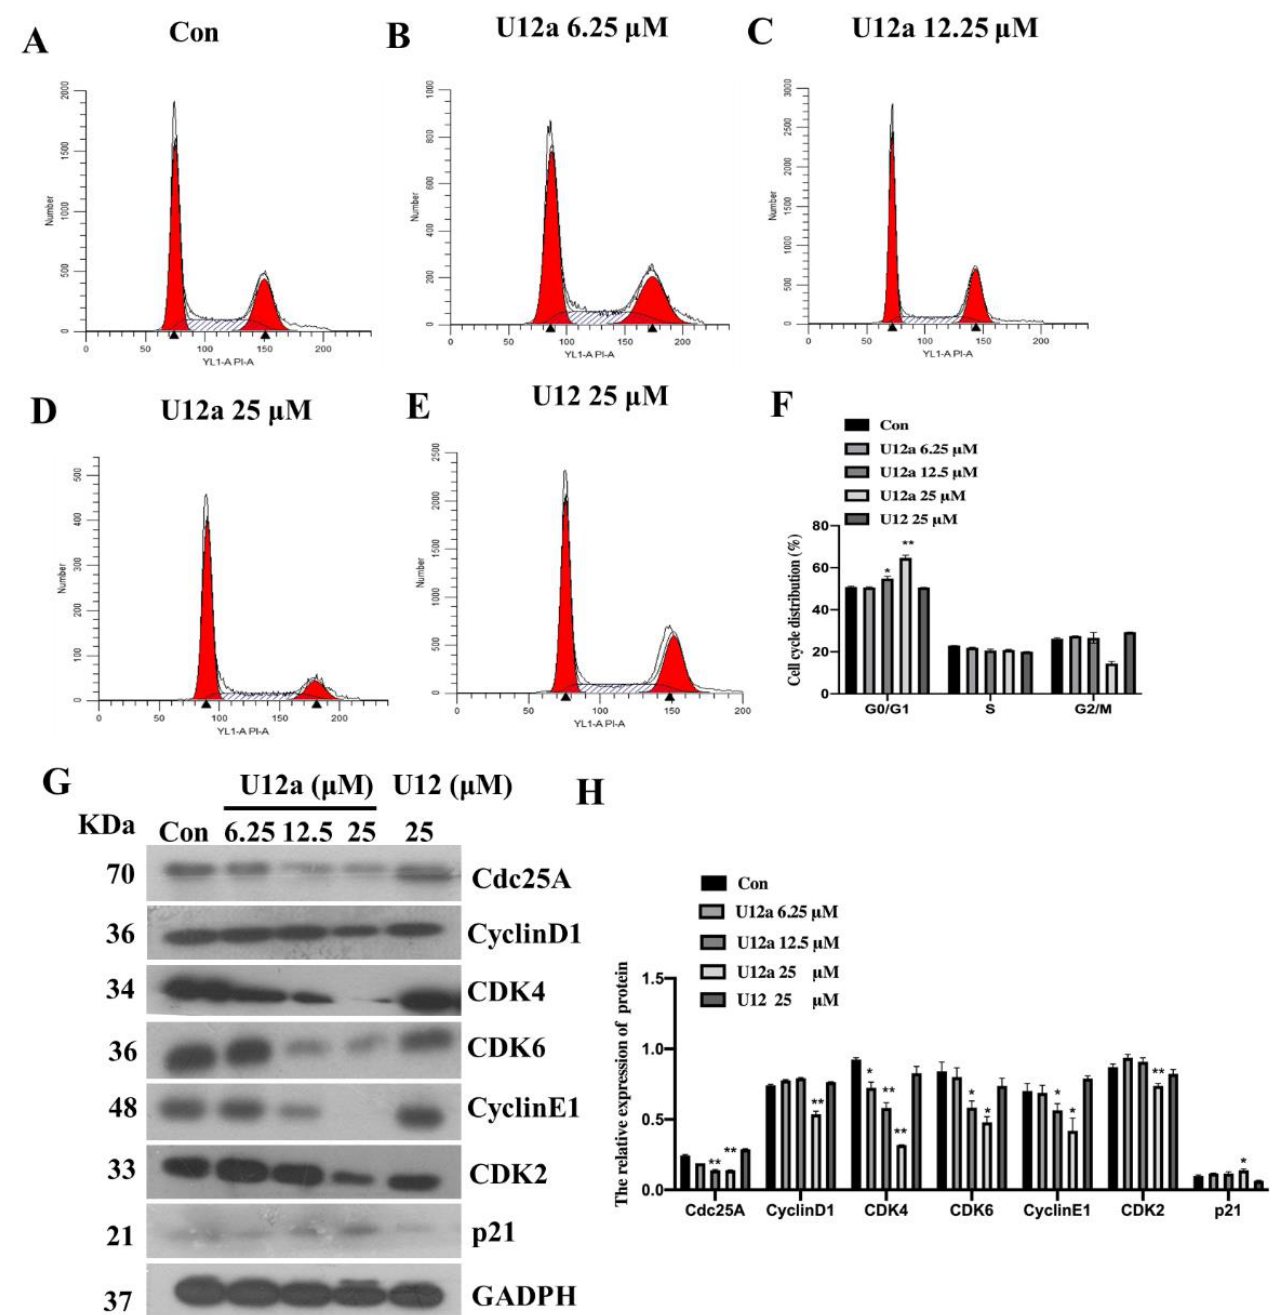
Figure 3. U12a inhibits HepG2 cell proliferation by arresting G0/G1 phase. ( A – F ) HepG2 cells were incubated with U12a (6.25,12.5,25 µ M) and U12 (25 µ M) for 24 h. Then all cells were harvested for further studies. Cell cycle analysis of HepG2 by flow cytometry. ( G and H ). Western blot analysis of Cdc25A, CyclinD1, CDK6, CDK4, CyclinE1, p21 and p27. All data represent the mean ± SD of three independent experiments. * p < 0.05, ** p < 0.01 vs. control group in the absence of any treat- ments.